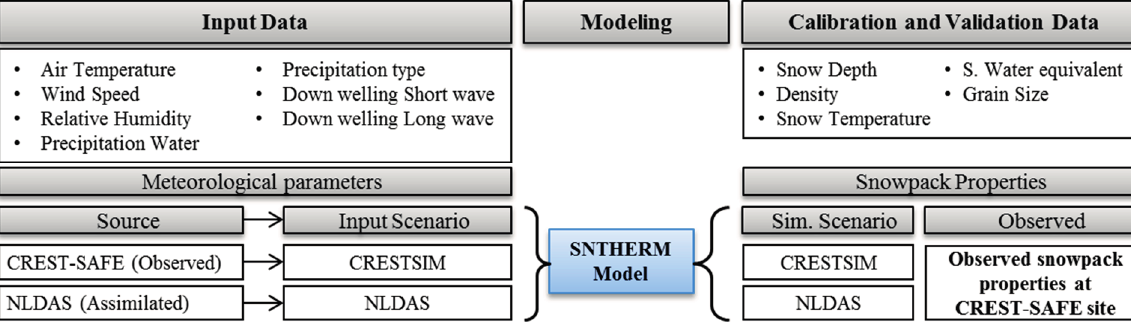
Figure 3. Flowchart of datasets, modeling setup, and general scope of work.